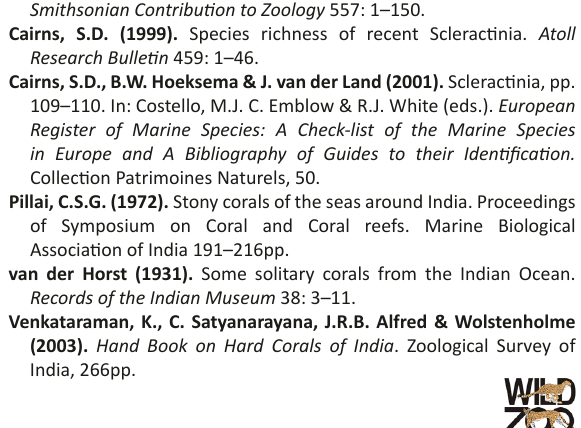
Table 1. Morphometric details of Paracyathus pruinosus Alcock, 1902 collected in Andaman and Nicobar islands.